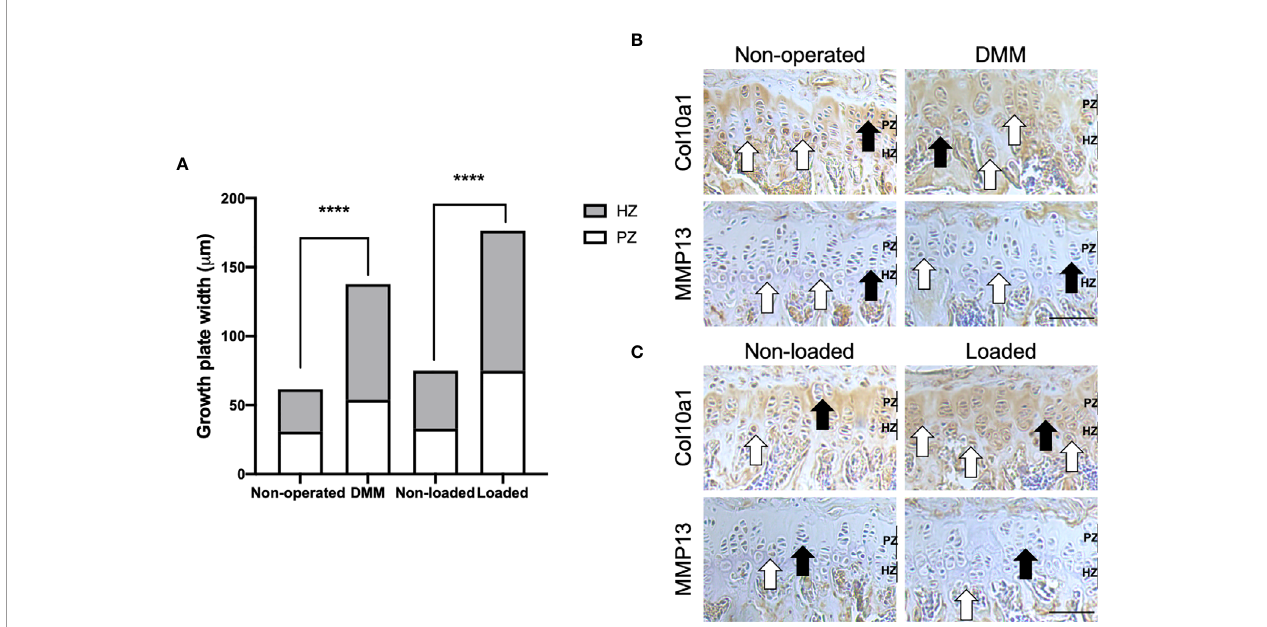
FIGURE 2 | Growth plate dynamics in the tibial growth plate of mouse knee joints. Growth plate zone width of non-operated and DMM, or non-loaded and loaded knee joints of C57BL/6 male mice (A) . Ten measurements per section were obtained along the length of the tibial growth plate in the middle region of the knee joint (n=4 mice for each experimental group). Immunohistochemical labelling for type X collagen (Col10a1) and matrix metalloproteinase (MMP13) in the 6 m m coronal sections of growth plate of DMM and non-operated (B) , or mechanically loaded and non-loaded (C) middle regions of knee joints of C57BL/6 male mice. White arrows indicate examples of positive labelling, and black arrows indicate a lack of labelling, in the tibiae. Images are representative of results in 4 individual mice. Scale bar = 100 m m. PZ, proliferative zone; HZ, hypertrophic zone **** p <